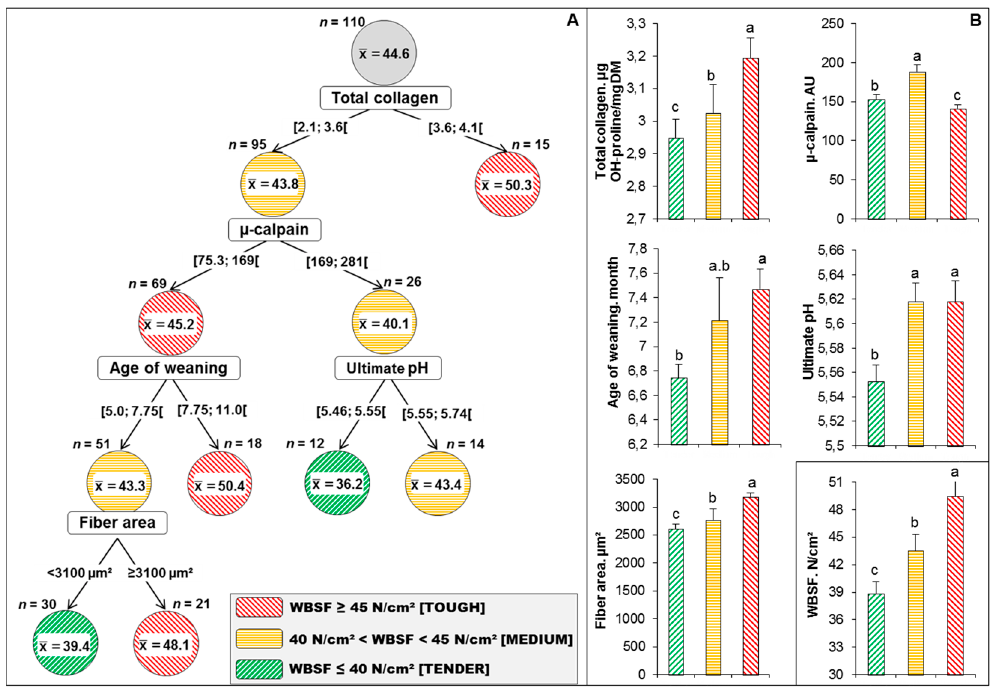
Figure 3. Categorization of the 110 steaks into di ff erent tenderness categories based on the decision tree. ( A ) Best decision tree obtained by the Chi-squared Automatic Interaction Detection (CHAID) method built using the list of variables retained in Table 5 to predict correctly 69.4% of WBSF values into three tenderness categories (Red: Tough meat; Orange: Medium meat; Green: Tender meat). The distribution of the animals in each WBSF cluster was used for accuracy measurement. At the beginning of the decision tree, all of the data ( n = 110) are concentrated at a root node located at the top of the tree. This was then divided into two child nodes on the basis of an independent variable (1st splitter = total collagen), that creates the best homogeneity. The cut-o ff value of each dividing splitter was calculated from the data of all the subjects. Therefore, the data in each child node are more homogenous than those in the upper parent node. This process is continued repeatedly for each child node until all of the data in each node have the greatest possible homogeneity. This node is called a terminal node and no more branches are possible. ( B ) Variance analysis on the variables retained by the CHAID decision tree among the three WBSF (tenderness) categories that were all significant at p < 0.05 (Tukey’s test). The mean values of WBSF among the three tenderness categories were further given at the bottom right of the graph B. Least-square means in the same graph with di ff erent superscript letters (a–c) are significantly di ff erent ( p <